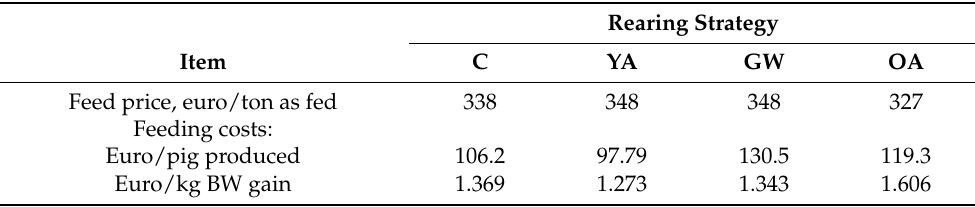
Table 7. Feeding costs of pigs raised according to the traditional (control, C), and three alternative strategies (younger age, YA; greater weight, GW; and older age, OA) a . Rearing Strategy Item C YA GW OA Feed price, euro/ton as fed 338 348 348 327 Feeding costs: Euro/pig produced 106.2 97.79 130.5 119.3 Euro/kg BW gain 1.369 1.273 1.343